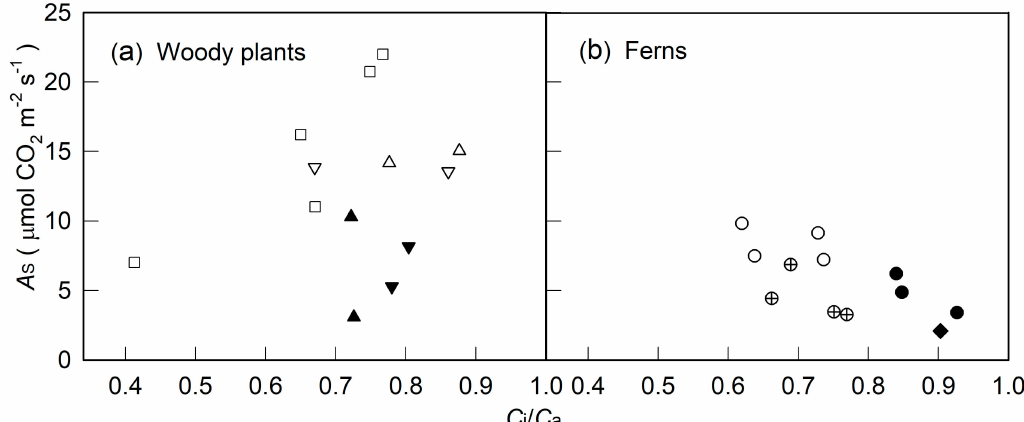
Figure 5. The relationship between net photosynthetic rate ( A S ) and the ratio of intercellular CO 2 concentration ( C i ) to atmospheric CO 2 concentration ( C a ) for woody plants ( a ), and ferns ( b ). All data were obtained from the steady-state light response at 2000 µ mol m − 2 s − 1 PPFD. (cid:3) is Alnus formosana ; (cid:52) is Salix Warburgii ; (cid:53) is Ficus microcarpa ; (cid:78) is Ardisia crenata ; (cid:72) is Ardisia cornudentata ; # is Pyrrosia lingus ; ⊕ is Asplenium antiquum ; • is Diplazium donianum ; (cid:117) is Archangiopteris somai . A S for ferns and understory shrubs measured at 75% relative humidity were from